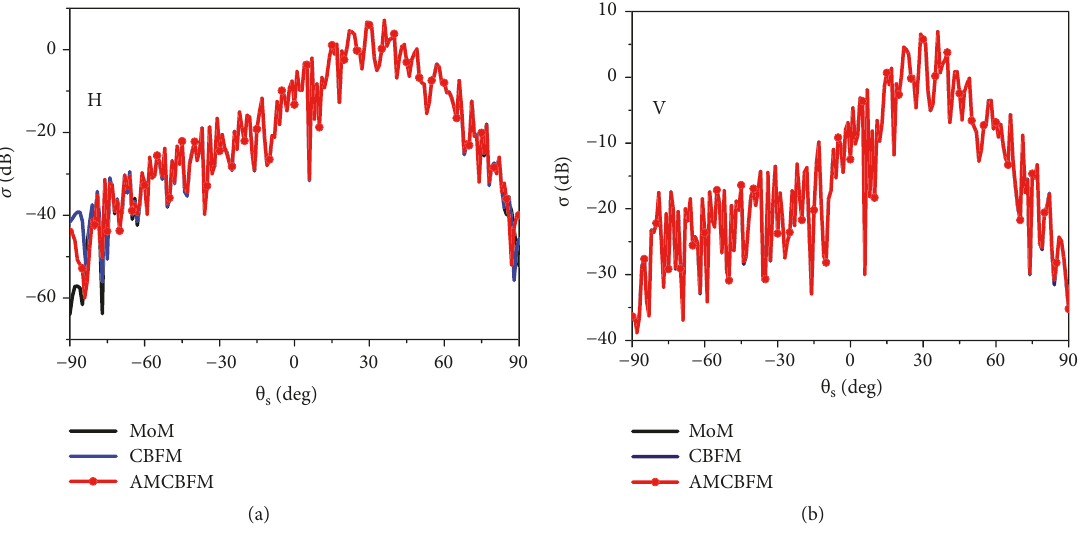
Figure 2: The bistatic scattering coefficients obtained by the different methods. (a) H polarization and (b) V polarization.